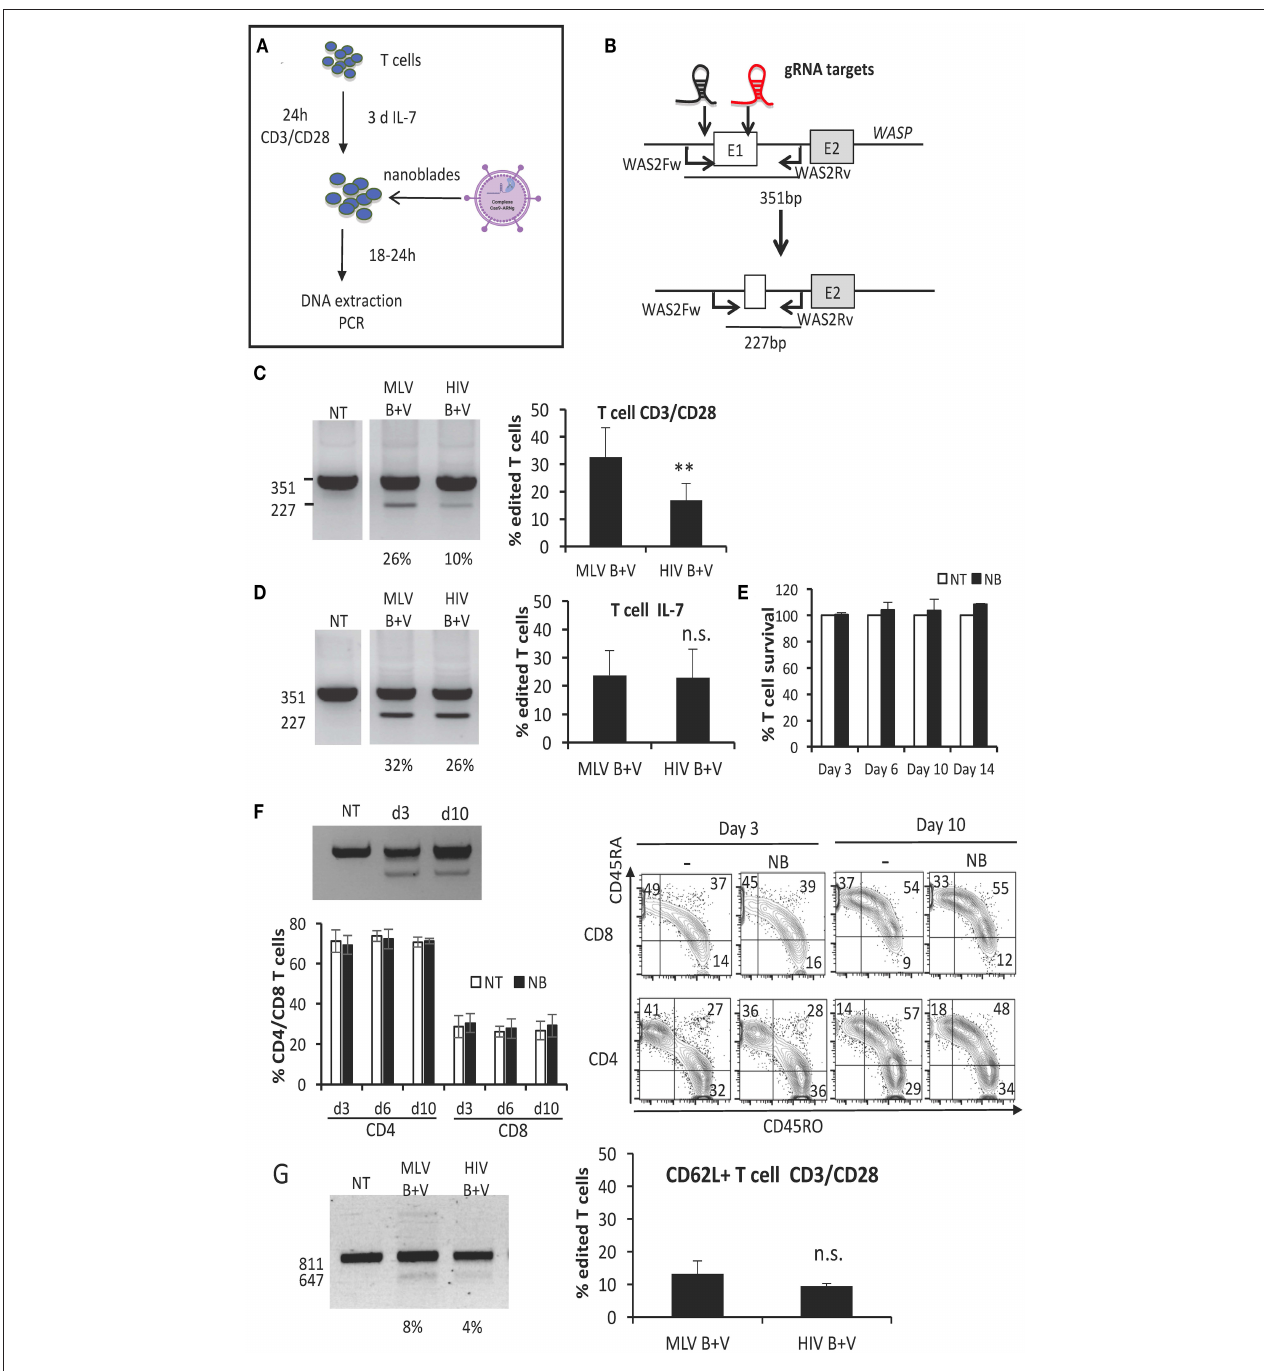
FIGURE 3 | BaEV/VSV-G gp displaying nanoblades allow efficient gene-editing in human T cells. (A) Outline of T cell activation and incubation with nanoblades for evaluation of CRISPR/CAS9 gene editing. (B) Schematic representation of expected band sizes of the PCR products using the WAS2Fw/WAS2Rv primer pair without cleavage (351 bp) and after gene-edited deletion into the WAS gene (227 bp); gRNA-301 and − 305 target sites are indicated as black and red gRNA, respectively. CD3/CD28 activated (C) or IL-7 stimulated (D) T cells transduced with MLV- or HIV-based nanoblades co-pseudotyped with BAEV- and VSVG-gps (B + V) in the presence of retronectin. (C,D) Representative electrophoresis gels of the PCR products using the WAS2Fw/WAS2Rv primer pair; percentage of edited T cells is indicated under each lane (left) and summarizing graph showing percentage of gene editing (right) (means ± SD, MLV B + V n = 3, HIV B + V n = 3; student t -test, ** p < 0.01, n.s, not significant). Survival (E) and gene editing (F) over time are shown for IL-7 stimulated T cells incubated with MLV nanoblades or not (NT) and continued in culture in the presence of IL-7 (means ± SD, NT n = 3, NB n = 3). Cell survival was determined by DAPI staining and is shown for the nanoblade